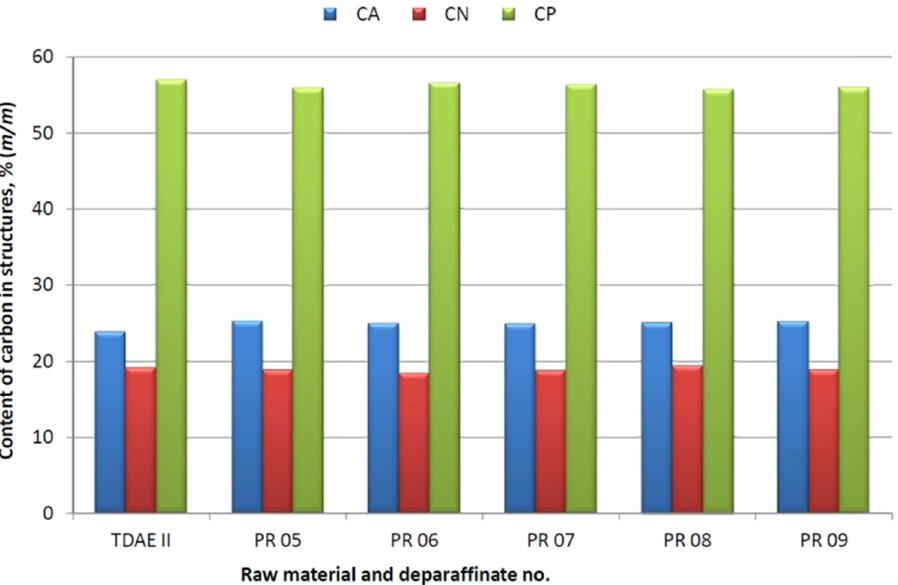
Figure 4: E ff ect of the dewaxing process with the MBIK – MEK solvent on the change of the structural composition of depara ffi nates – TDAE II raw material.